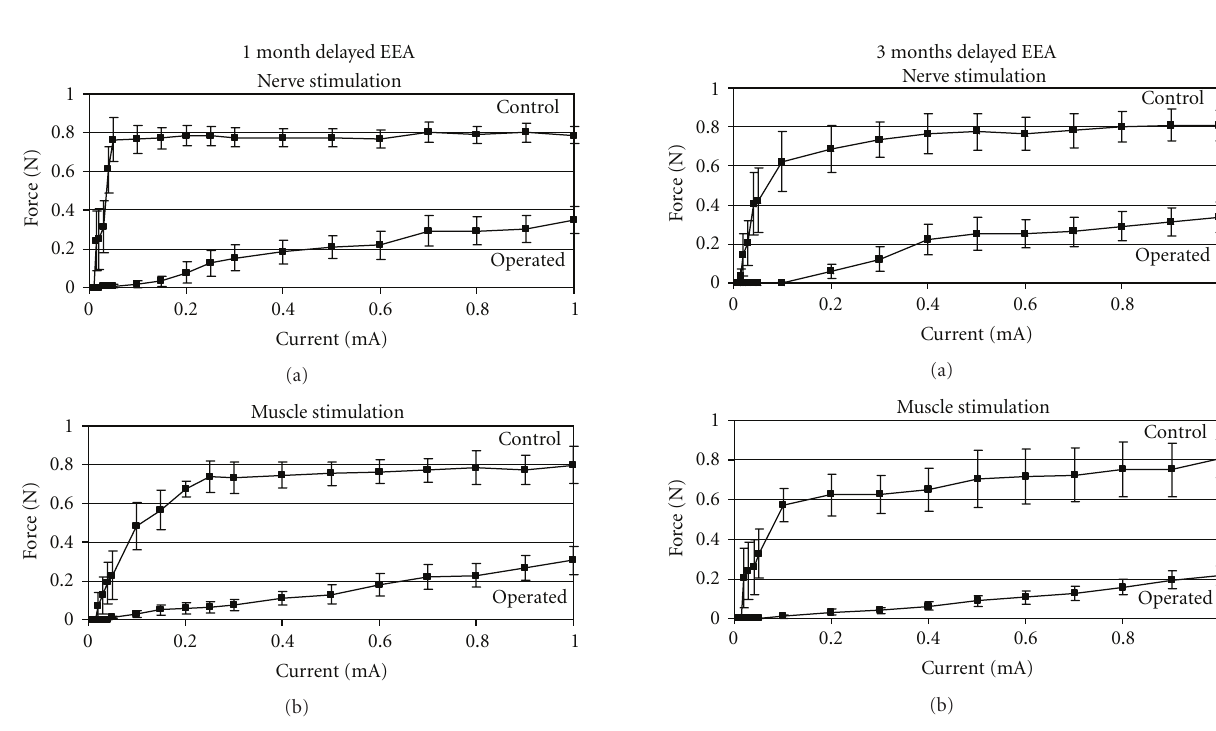
Figure 6: Force-current characteristics of the SM muscle in the 1- month delay EEA group. Muscle force in the operated and control SM muscles was produced by nerve stimulation (a) or by direct muscle stimulation (b). Note that the delayed reinnervation of the SM muscle produced a smaller muscle force as compared with immediate reinnervation (illustrated in Figure 5).